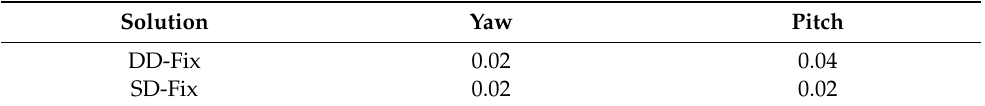
Table 4. STDs of yaw and pitch angles between DD-Fix and SD-Fix after multipath mitigation / ◦ .